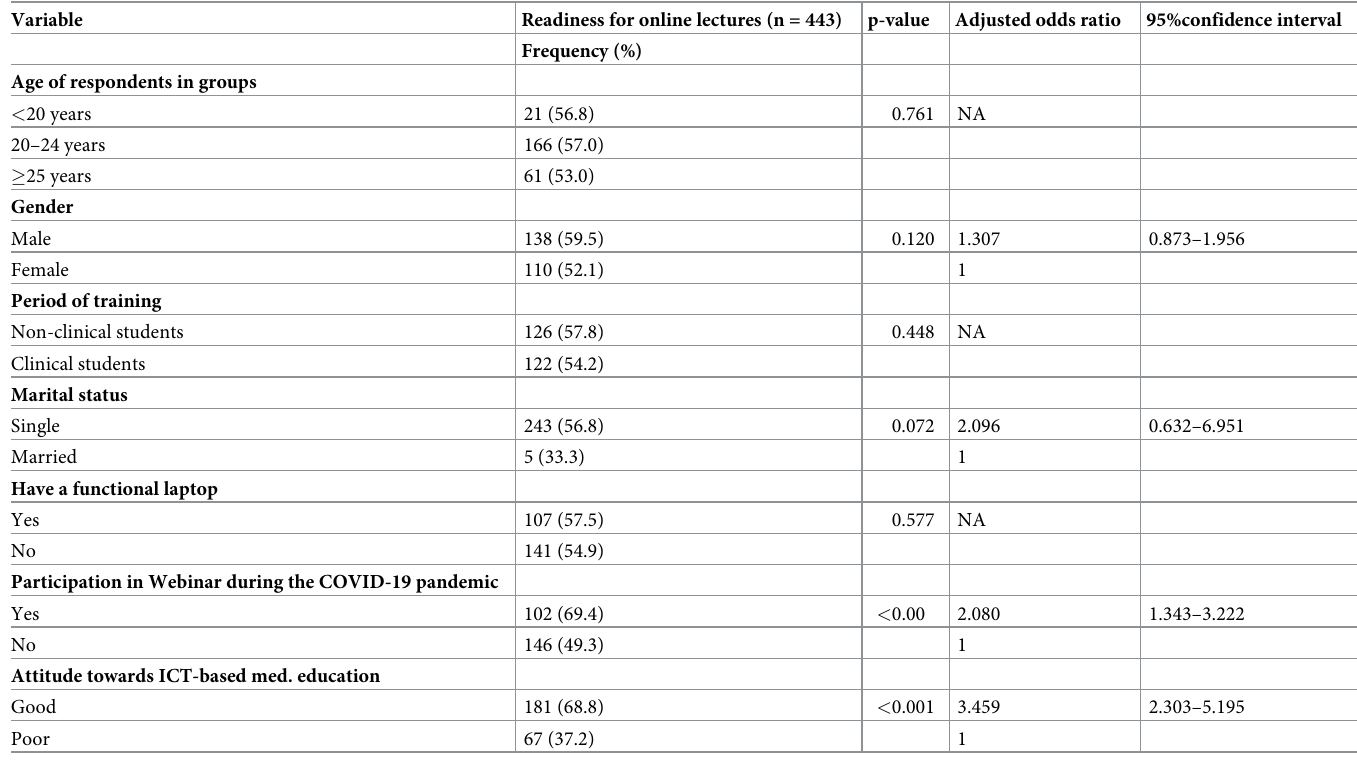
Table 6. Predictors of readiness for online medical education among the